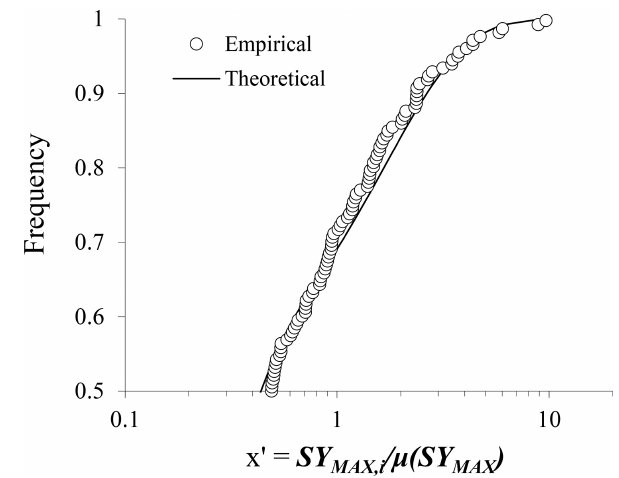
Figure 4. Comparison between empirical and theoretical CDF of the variable x (cid:48) for the 9 investigated datasets.